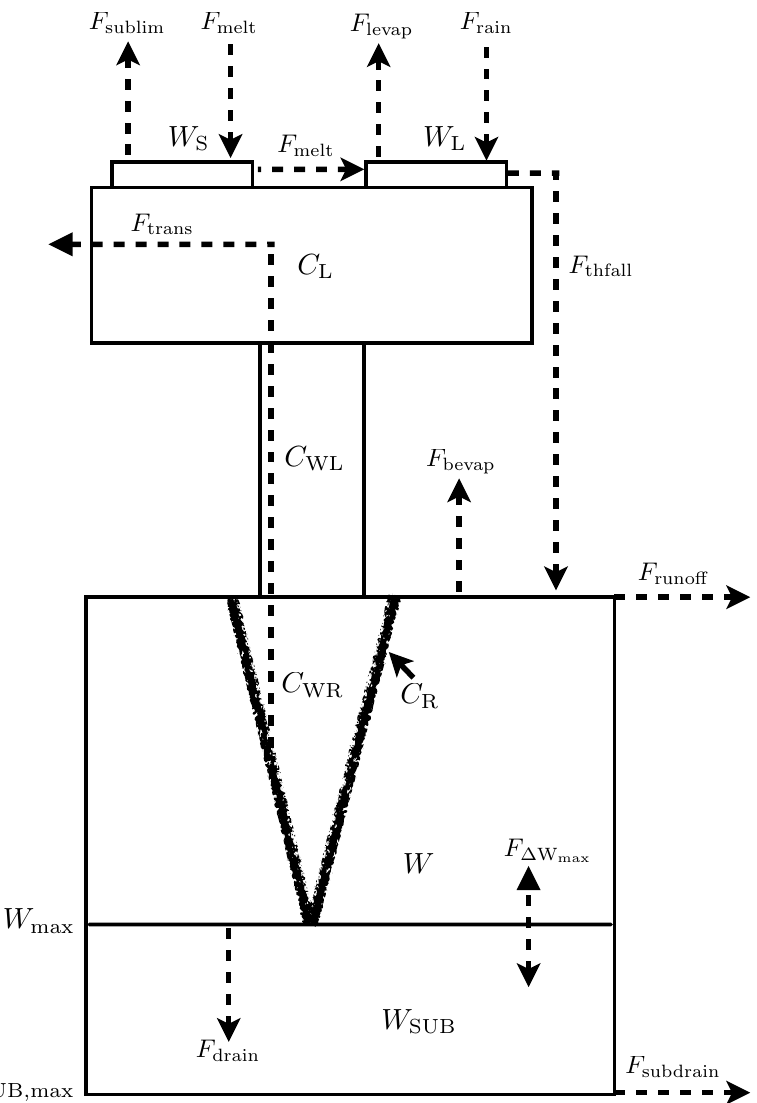
Fig. B1. Schematic diagram of the land surface module. For symbols, see Tables C4, C3, C6, and C7.